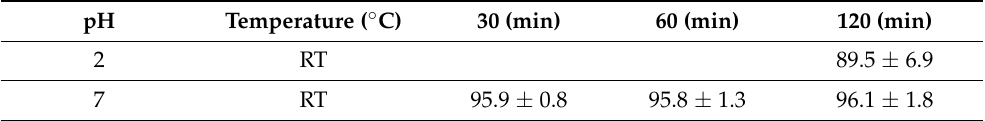
Table 2. Percentage (%) of radiolabeling yield of [ 99m Tc]Tc-DPD-Fe 3 O 4 DMCAs incubated at pH 2 and 7, as a function of incubation time at room temperature (RT). The results are expressed as mean value ± standard deviation of at least three independent experiments.